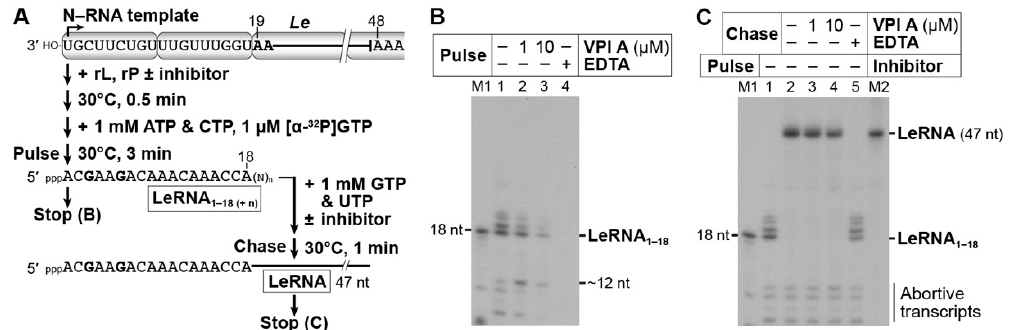
Figure 7. VPI A inhibits VSV LeRNA synthesis. As illustrated in ( A ), the VSV RdRp sequentially transcribes the genome in the N–RNA complex into the leader RNA (LeRNA) and 5 ′ -capped and 3 ′ -polyadenylated mRNAs. In vitro transcription was performed with VSV RNP in the presence or absence of 1 or 10 µM VPI A. LeRNA and deadenylated mRNAs were analyzed by 20% ( B ) or 5% ( C ) urea-PAGE followed by autoradiography. The graphs show relative RNA synthesis activities, where radioactivities of each product synthesized without and with RNP (B and C, lanes 1 and 2, no drug) were set to 0 and 100%, respectively. Statistical significance was determined by one-way ANOVA (*, p < 0.05; **, p < 0.01; compared to control (column 2)).